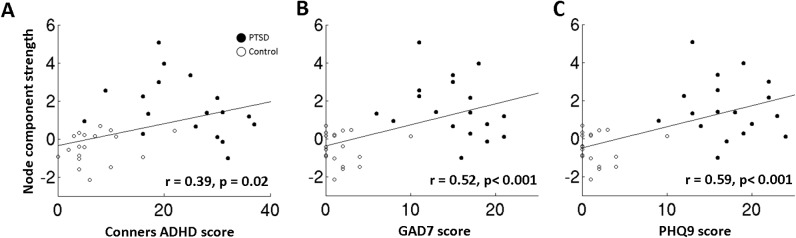
Right parietal theta in the Extra-dimensional task correlates with combined group cognitive assessment in the Conners ADHD, GAD7 and PHQ9 test scores.
(A) Scatterplot showing a significant positive correlation between right superior parietal lobule theta connectivity strength within the hyperconnected network component during the more difficult Extra-dimensional set-shifting task in the 100–300 ms time window versus Conners ADHD test score, at the combined group level. (B) Same as before, but for the GAD7, (C) and for the PHQ9.